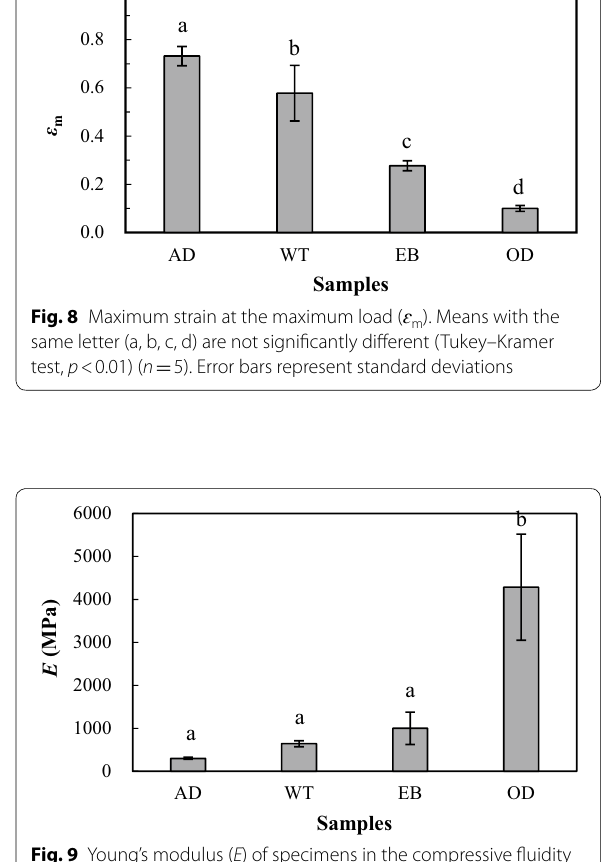
5). Error bars represent standard =